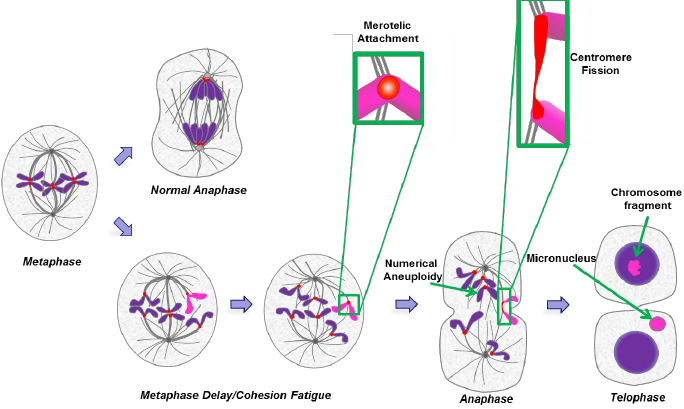
Figure 4. Numerical and segmental aneuploidy as an outcome of cohesion fatigue and centromere fission. A cell at metaphase will normally undergo balanced chromosome segregation in normal anaphase (upper path). If metaphase is delayed (lower path), chromatids may begin to undergo cohesion fatigue and separate. When sister chromatids separate they may both move to one of the two spindle poles leading to numerical aneuploidy following anaphase and mitotic exit. In other cases the kinetochore of an individual chromatid may undergo merotelic attachment to microtubules from both spindle poles (exemplified by sequential stages for the pink chromatid and detailed in the green boxes). Under this circumstance, spindle forces or cytokinesis may sever the chromatid resulting in chromosome fragments that can attach to other chromosomes resulting in segmental deletions, duplications, translocations and the formation of micronuclei. The study of cultured cells from mutant mice and analysis of human cancers of recent origin have led to a proposal that segmental aneuploidy defects involve whole chromosome arms that arise through “centromere fission,” breaks at or near centromeres [107,108]. Light and electron micrographs show that, under certain conditions, merotelically attached kinetochores undergo